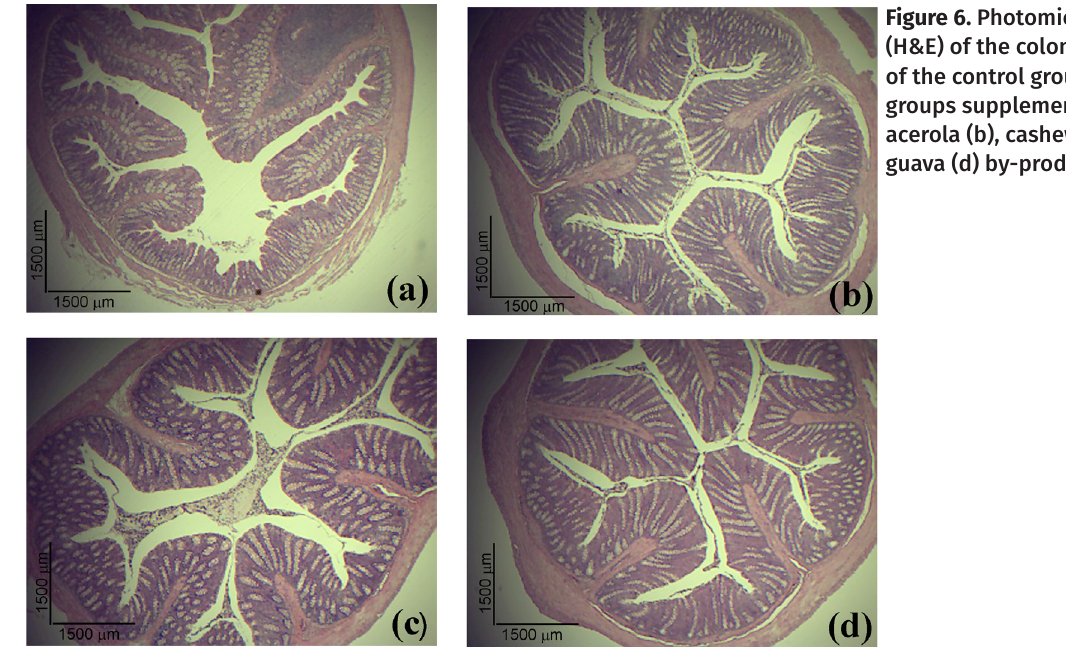
Figure 6. Photomicrographs (H&E) of the colons of rats of the control group (a) and groups supplemented with acerola (b), cashew (c) or guava (d)